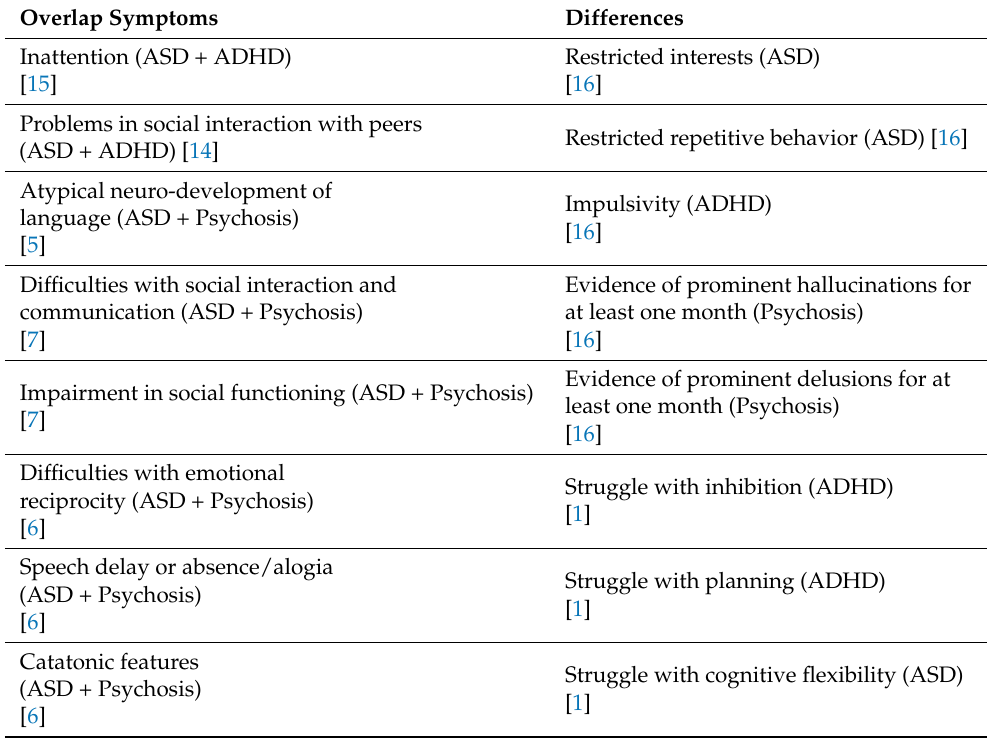
Table 1. Overlap symptoms and differences between ADHD, ASD and psychosis. Overlap